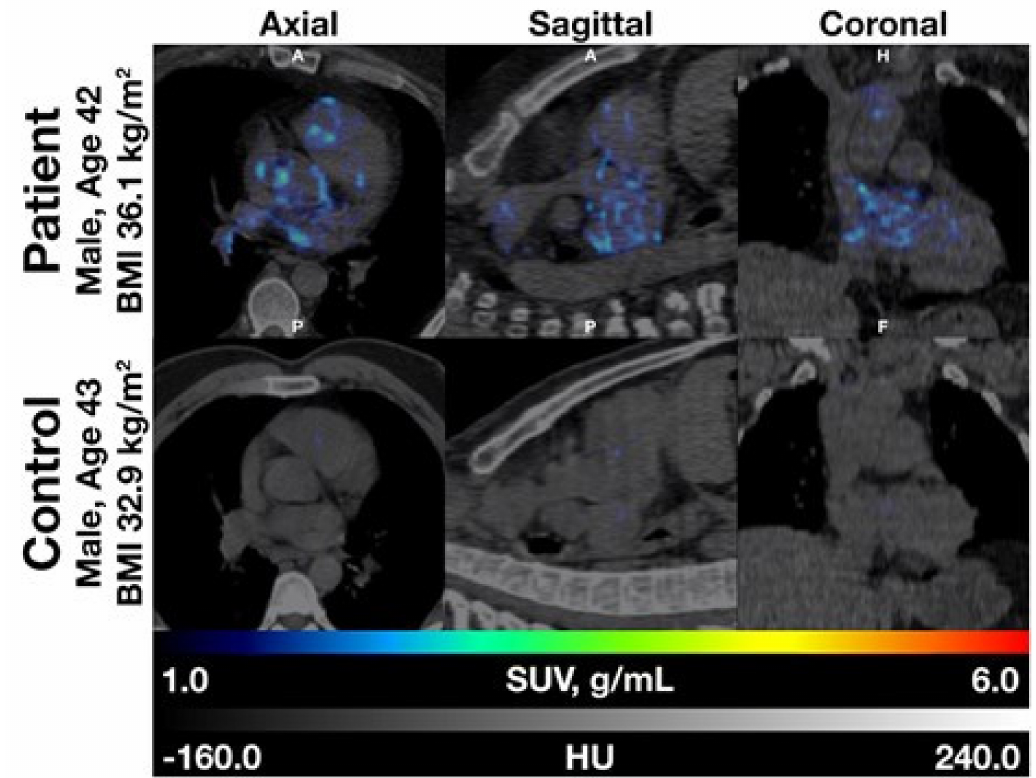
Figure 1. Fused NaF-positron emission tomography / computed tomography images of patient (top) and matched control (bottom). Note that the distribution of NaF uptake in the patient does not follow only the epicardial routes of the three coronary arteries, but is more dispersed, suggesting that NaF uptake is present in the walls of the entire cardiac arterial tree (with permission from reference [4]). Coronary arterial contrast-enhanced imaging would help address the